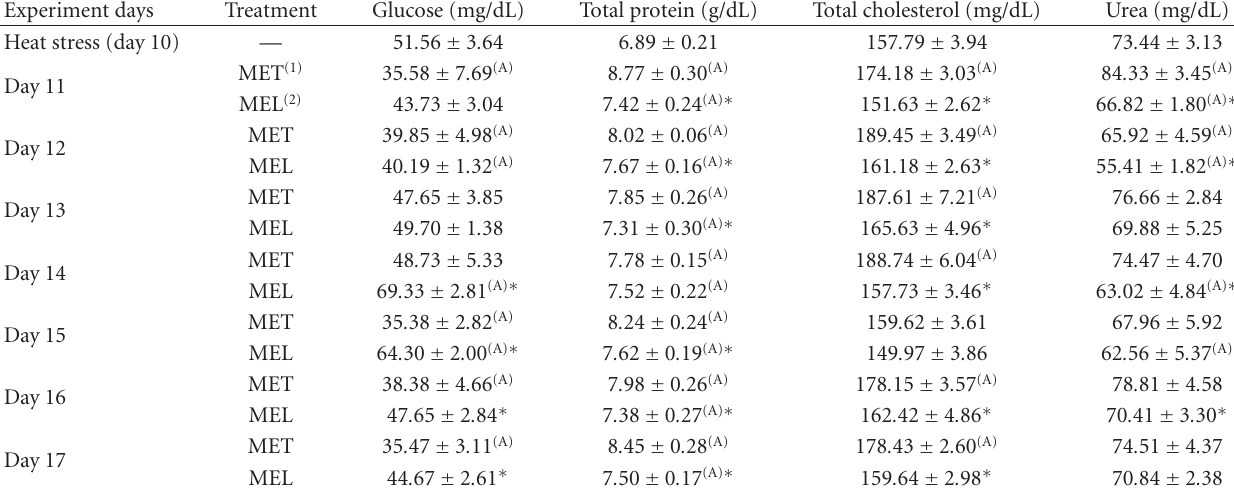
Table 2: Mean and SE of biochemical parameters in blood plasma of heat exposed, chemically adrenalectomized, and melatonin administered goats. Values are mean and SEM.